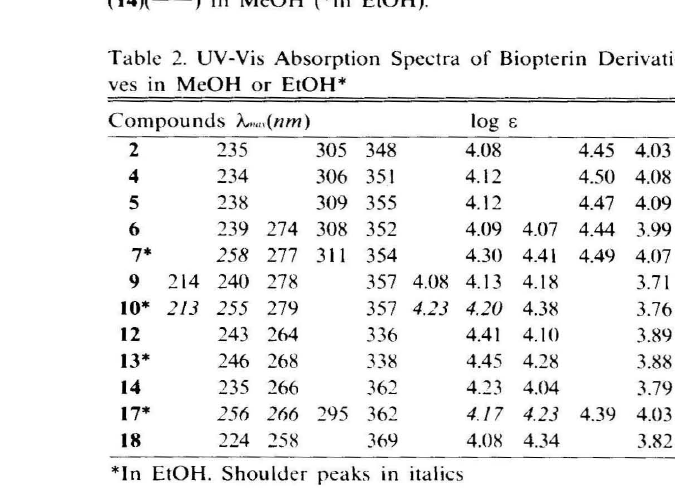
Figure I. UV /Vis Ahsorption spectra of 3-methylhiopterin (9) (-----). 3-NPE-biopterin (10) (-----)*. and O'-methylhiopterin (14)(--) in MeOH (*in